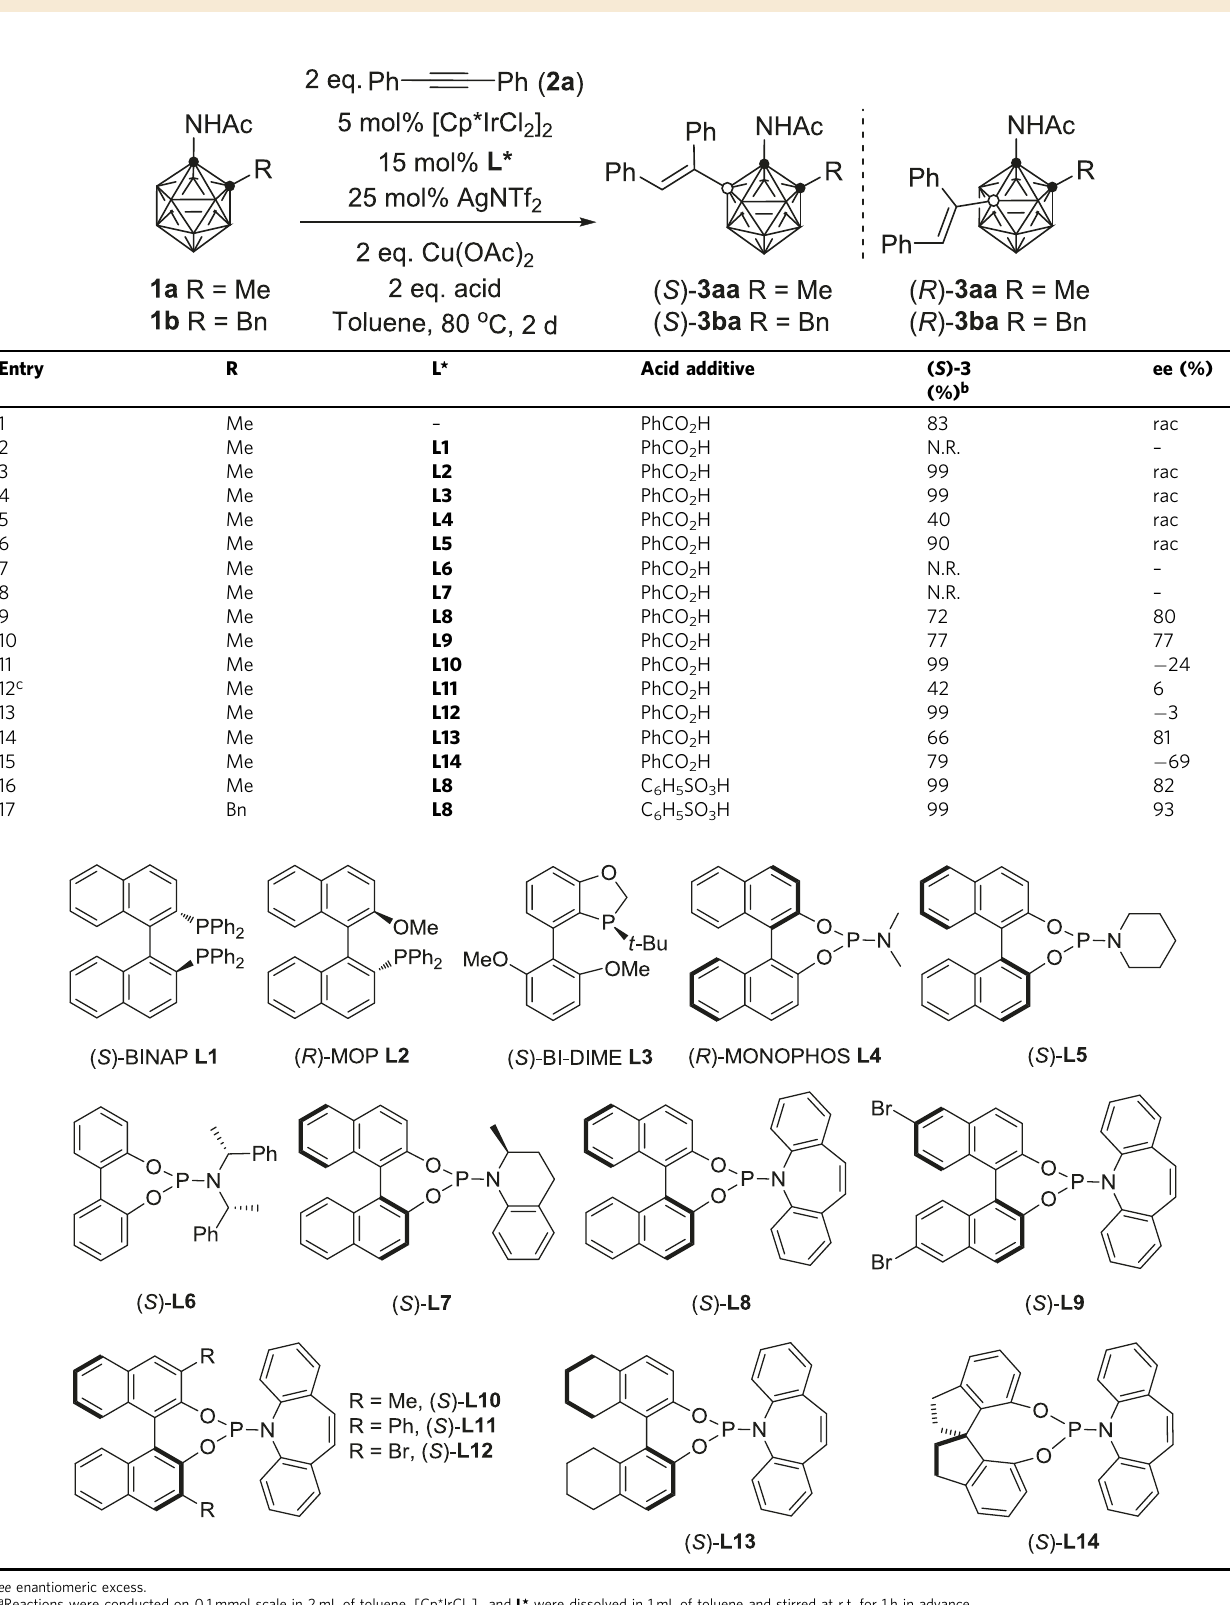
Table 1 Screening of chiral ligands and additives a